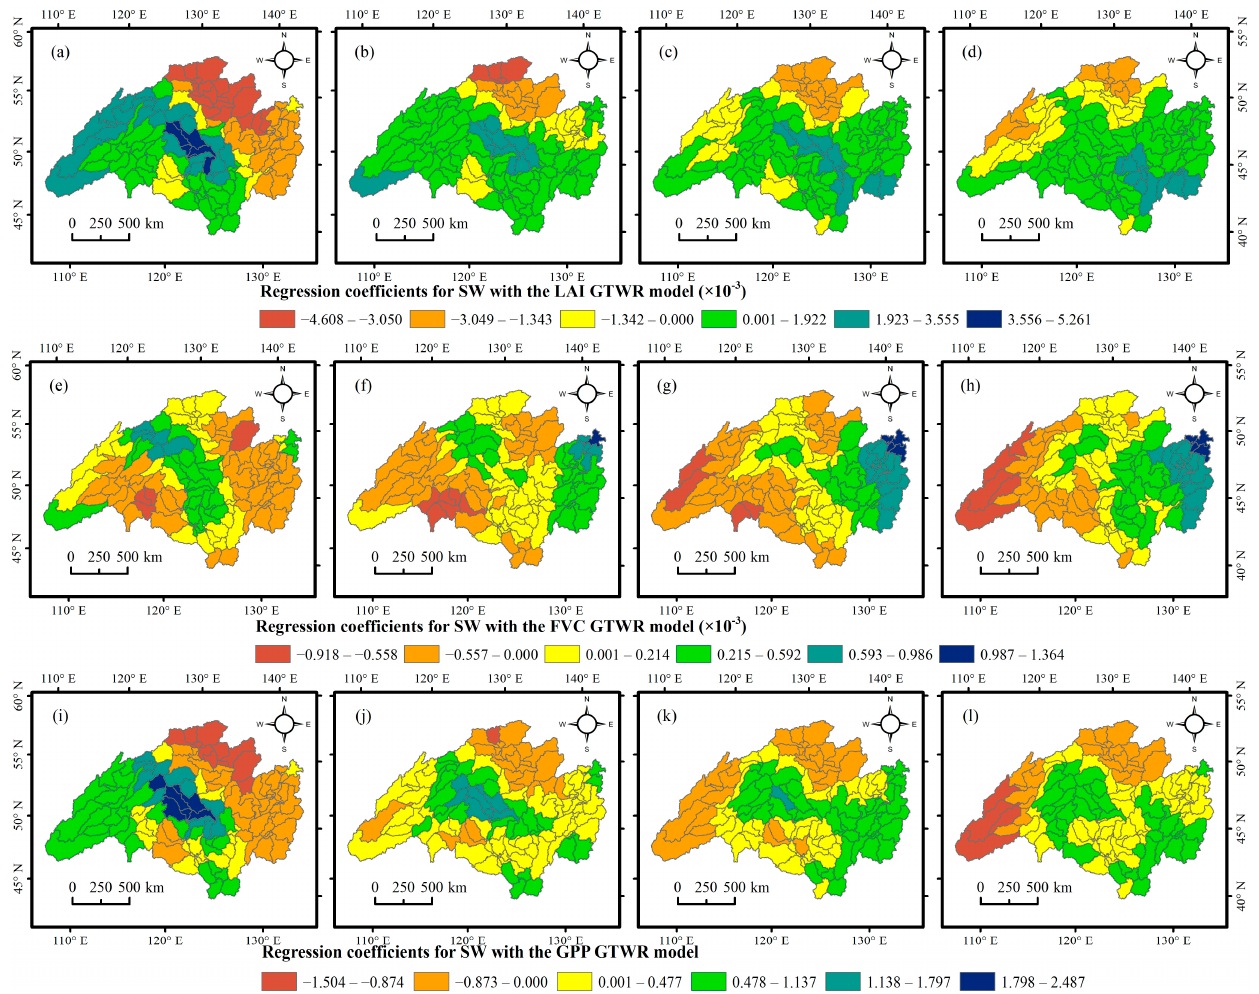
Figure 9. The spatial distribution of the regression coefficients for SW with the LAI (( a – d ) shows the coefficients for Periods 1–4, respectively), FVC (( e – h ) illustrates the coefficients for Periods 1–4, respectively), and GPP (( i – l ) presents the coefficients for Periods 1–4, respectively) GTWR models for the four studied periods.